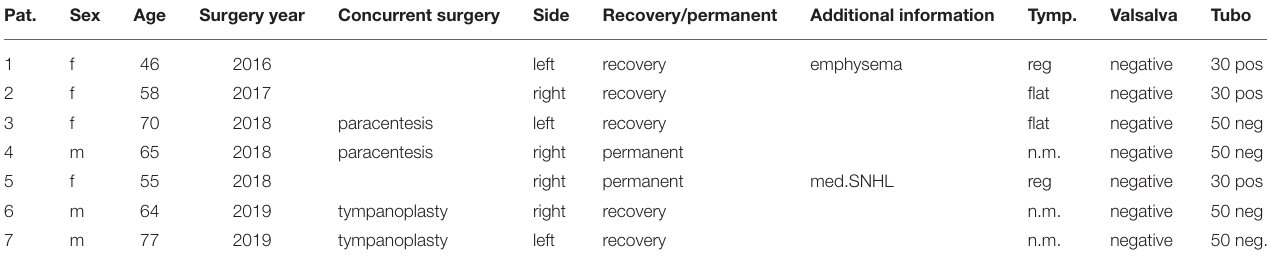
TABLE 1 | Individual data of patients with hearing loss after BET, Tymp. indicates tympanometry results, n.m. means not measured; Valsalva result, and tympanomtry results in mmHg opening pressure (50 neg, means no opening could be observed).